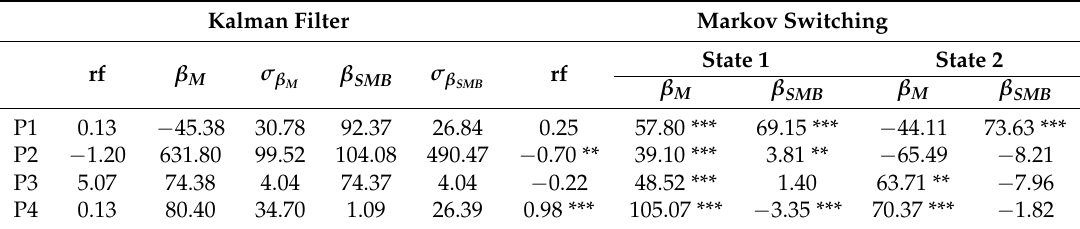
Table 3. β estimation with the SMB